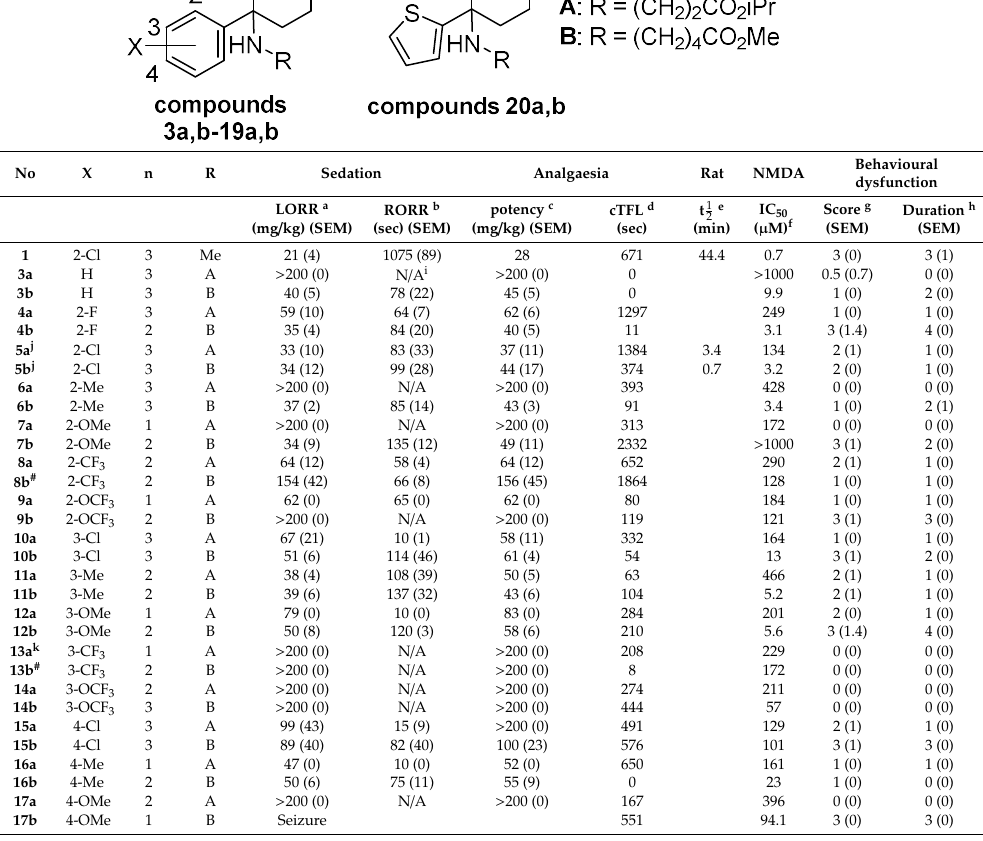
Table 1. Biological and physiochemical data for esters of ring-substituted ketamine analogues.